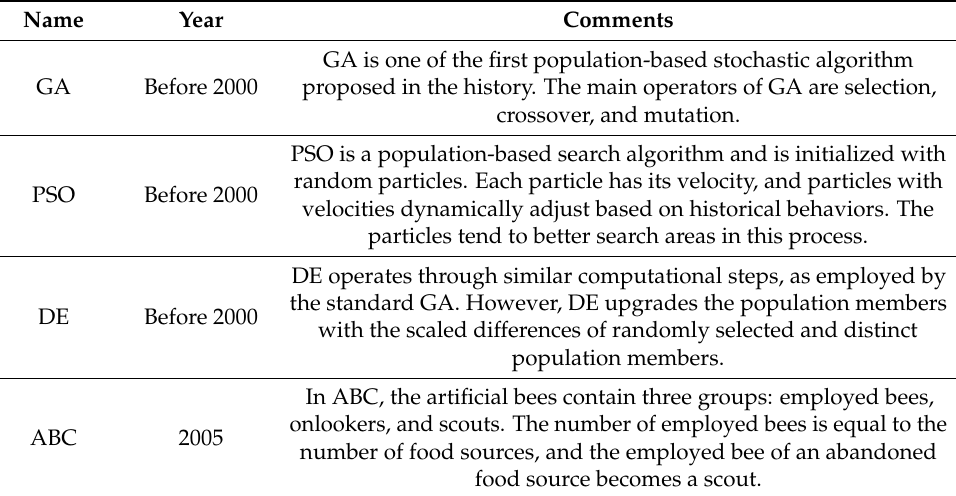
Table 1. Specific information of the ten